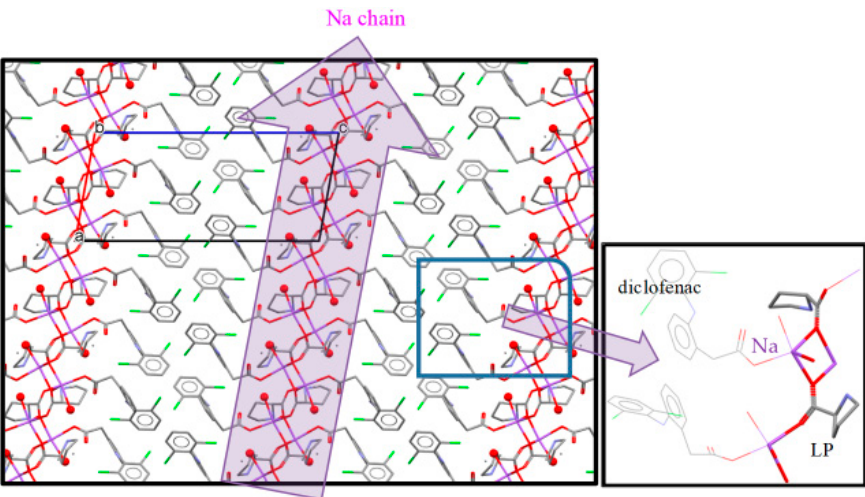
Figure 13. The order of diclofenac–sodium–proline (NDP) system. L-proline (LP) allows Na + to form a coordination work with diclofenac site. Na + is in violet.